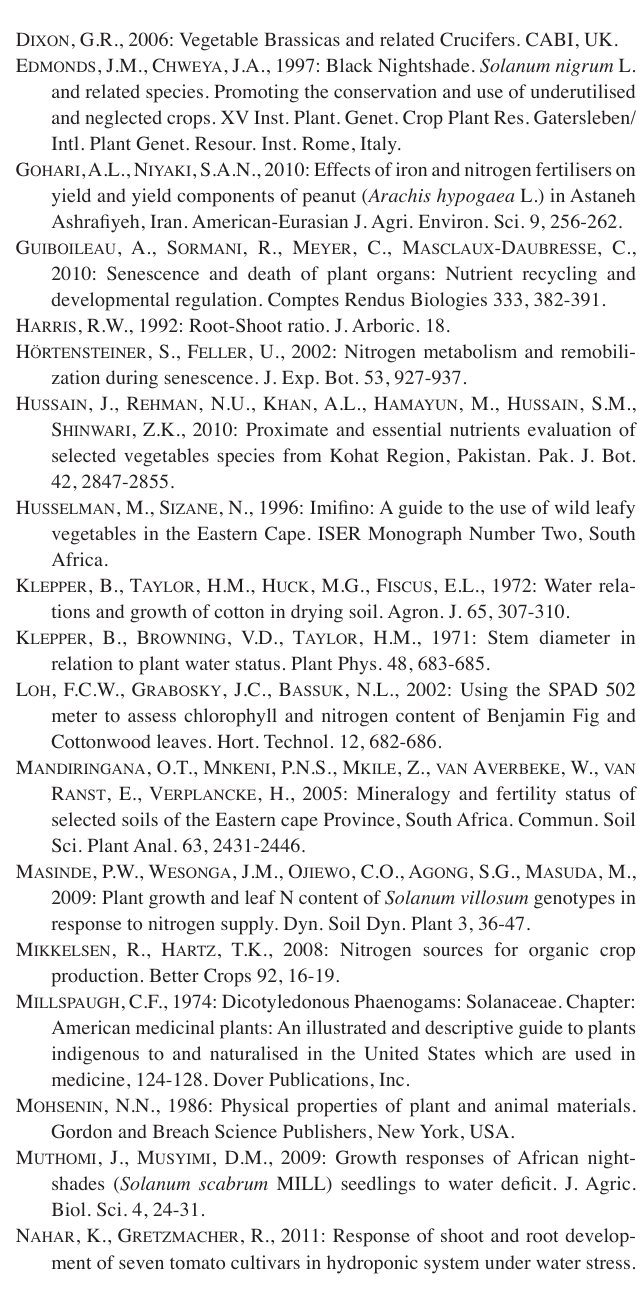
Plant age (Weeks after